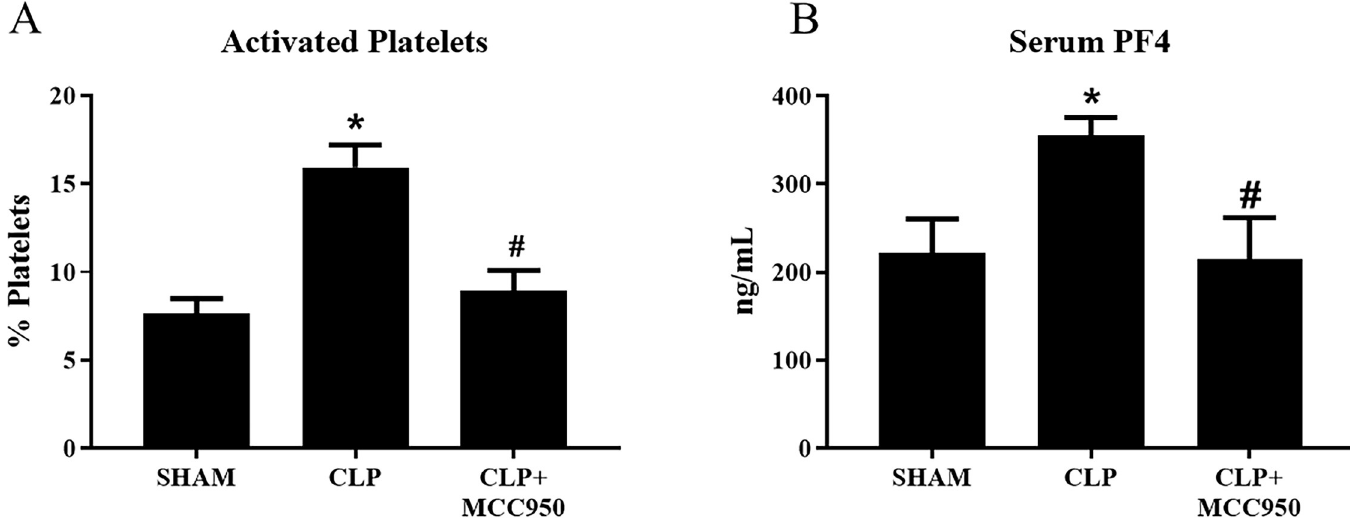
Fig 3. Platelet activation. Platelets were isolated from Sham, CLP, and CLP+MCC950 (n = 10/group) and assessed for activation via flow cytometry. Serum platelet factor 4 (PF$) was assessed via ELISA (n = 10/group) � p < 0.05 vs Sham, #p < 0.05 vs CLP.